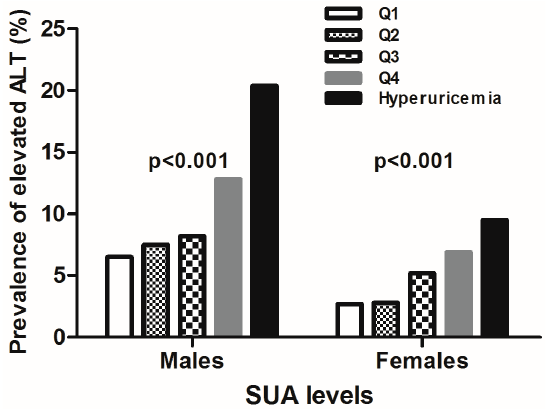
Figure 1. The proportion of adults with elevated ALT categorized by the uric acid level in both genders.